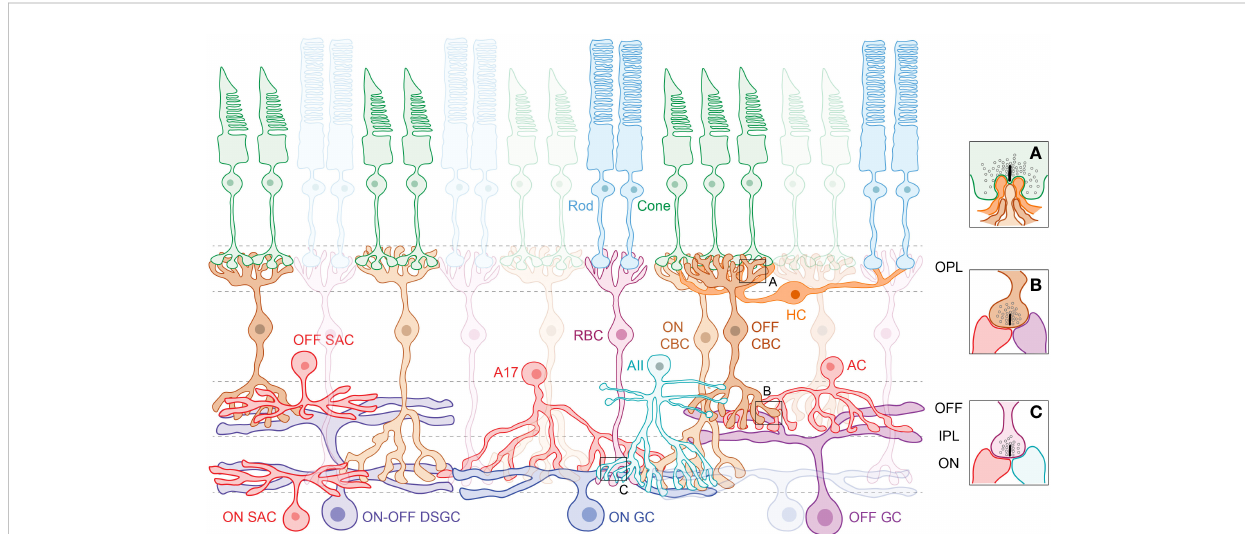
FIGURE 1 The retinal schematic highlights the cellular diversity and the need to trace physical connections between neurons and circuits. Photoreceptors in the outer retina, the rods and cones, synapse with respective rod (RBC) and cone bipolar cells (CBC) and form ribbon synaptic ‘ triads ’ with horizontal cell (HC) interneurons (A) in the outer plexiform layer (OPL). Amacrine cell (AC) interneurons modulate information fl ow in the inner plexiform layer (IPL), where the RBCs and CBCs relay signals to retinal ganglion cells (GCs). Note that CBCs synapse with both ACs and GCs (B) at ribbon synaptic ‘ dyads ’ , whereas RBCs synapse exclusively with ACs (C) . Processes of retinal neurons are segregated into distinct ON and OFF sublaminae in the IPL – ON cells that depolarize to light increments laminate deeper in the IPL, whereas OFF cells that depolarize to light decrements laminate super fi cially. Subtypes of ACs serve speci fi c visual functions, such as the AII, which conducts rod-driven signals to retinal output pathways, the A17 that provides feedback inhibition onto the RBC, and the starburst amacrine cells (SACs) that are integral to the direction-selective (DS) circuit ( Left